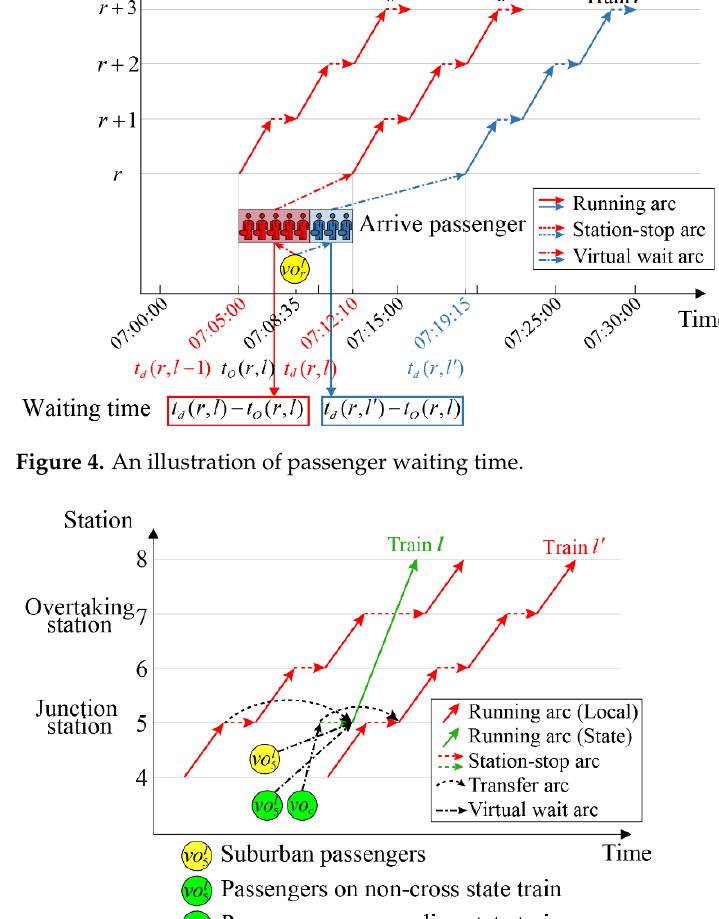
Figure 4. An illustration of passenger waiting time.